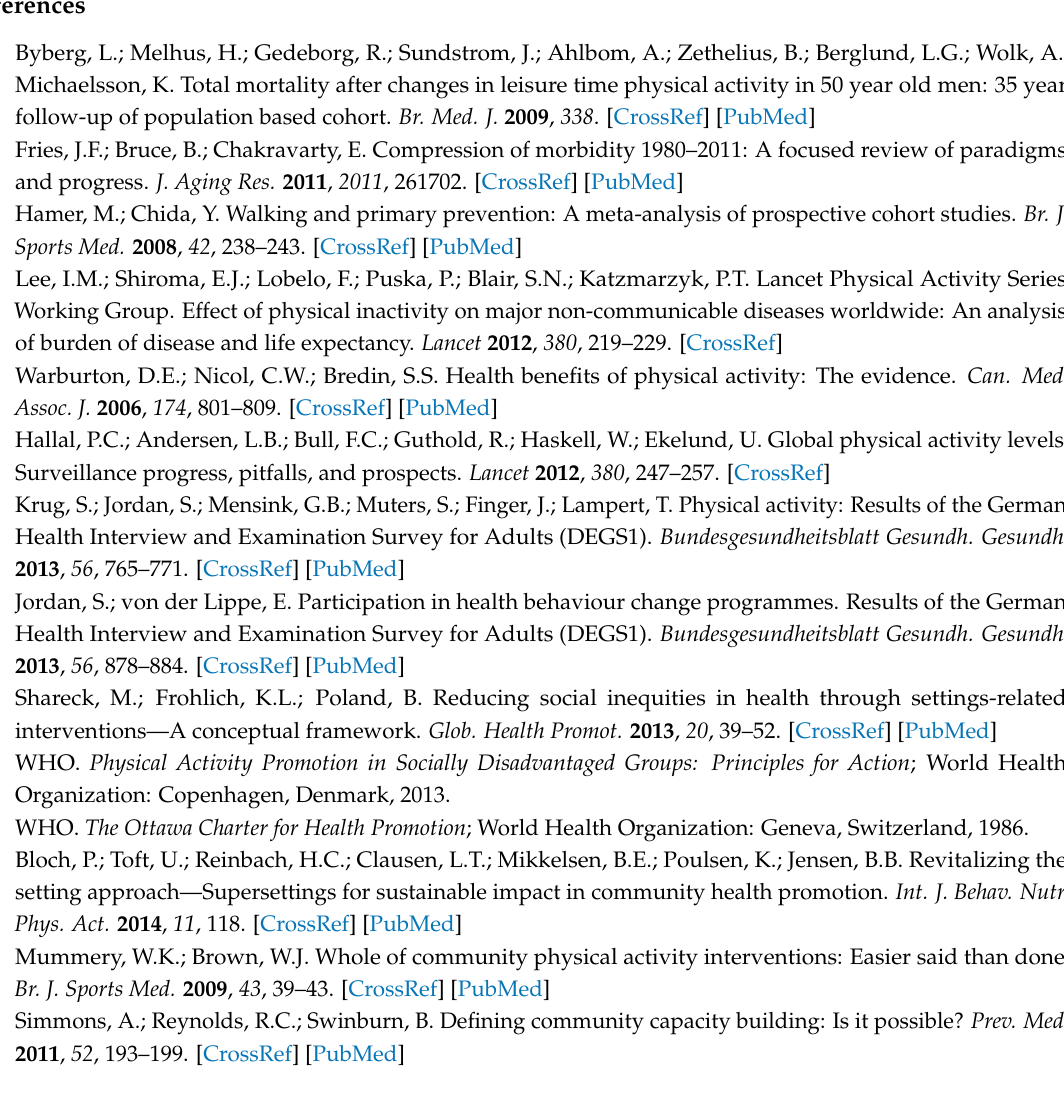
Table S1: Search strategy (Web of Science), Table S2: Search strategy (PsycInfo), Table S3: Quality assessment of case studies, Table S4: Quality assessment of randomized controlled studies, Table S5: Quality assessment cross-sectional studies, Table S6: Quality assessment cohort studies, Table S7: Overview of applied quality assessment